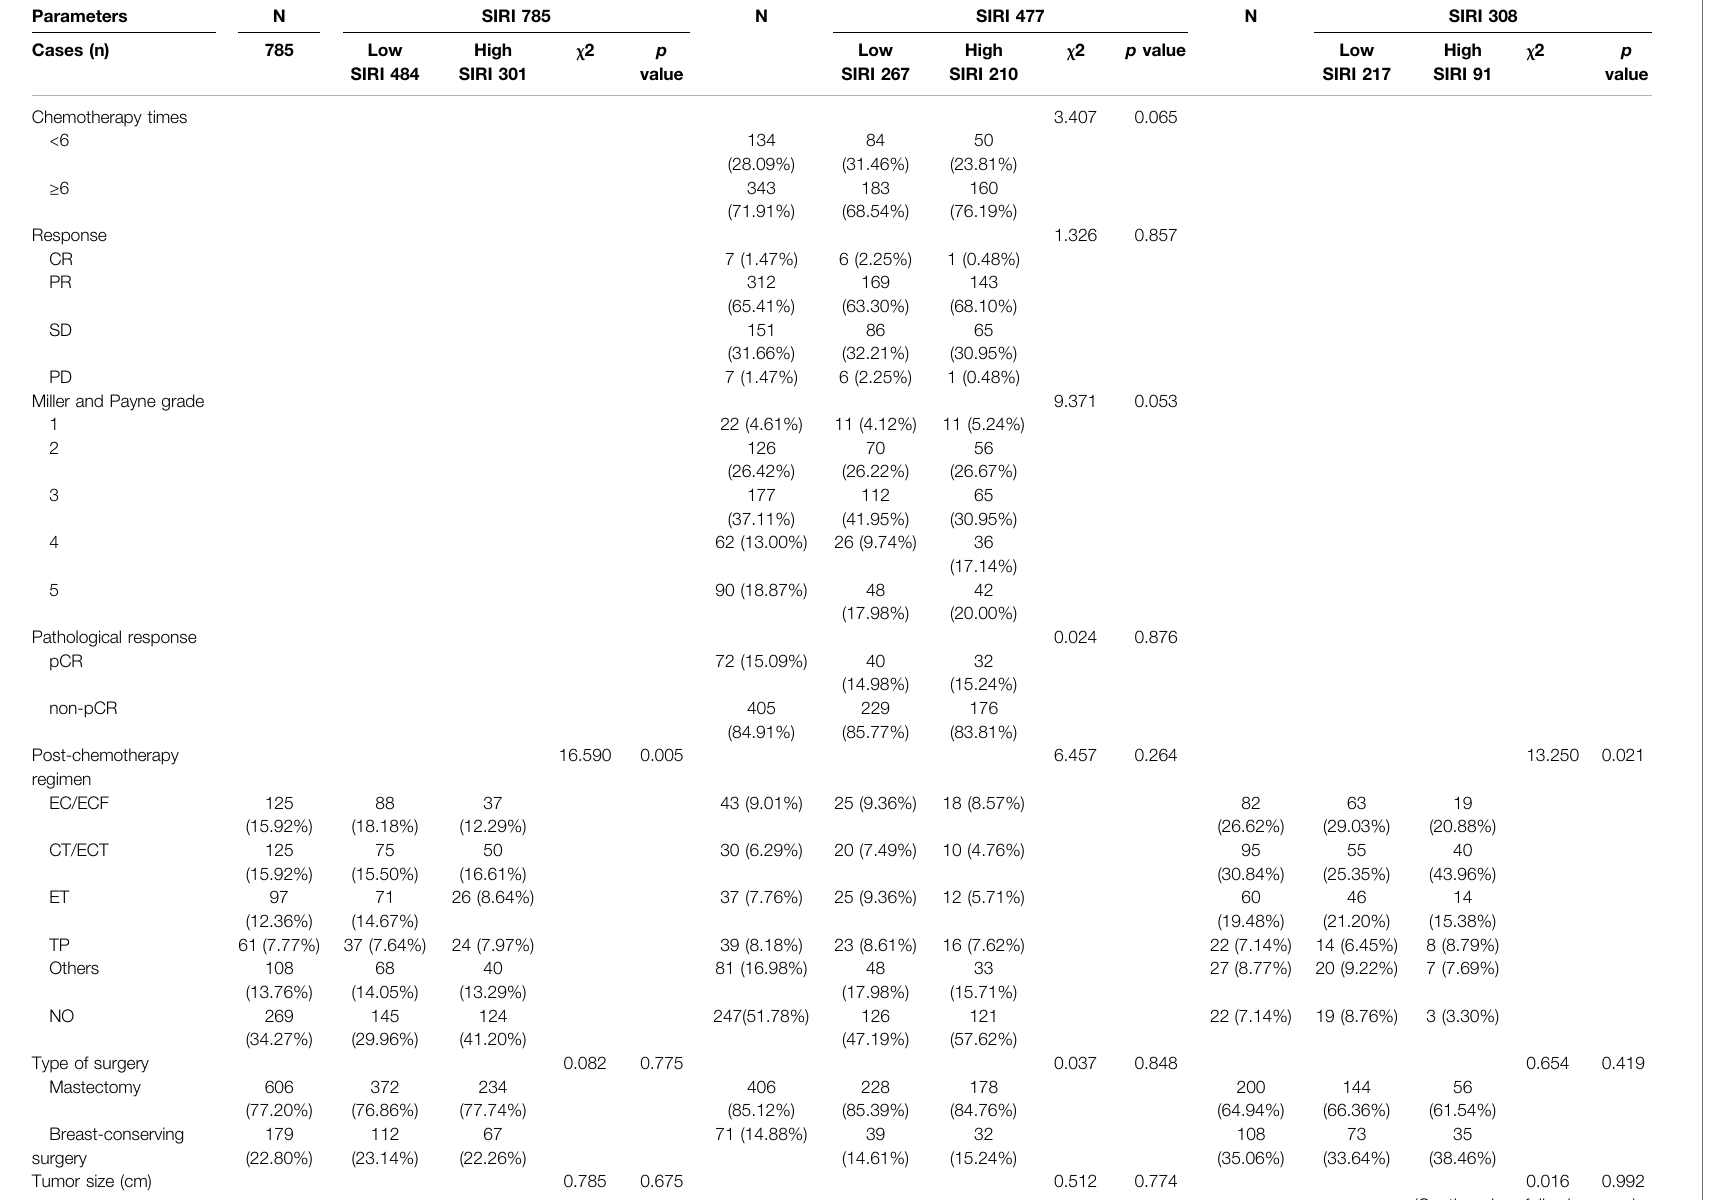
TABLE 1 | ( Continued ) Demographic and clinicopathologic characteristics of 785 patients with breast